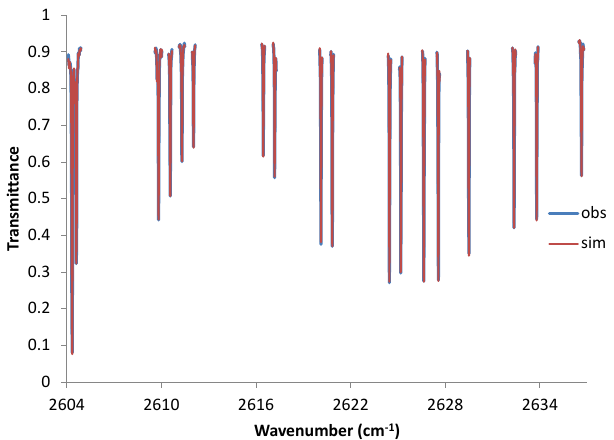
Figure 3d. Same as Fig. 3c but for TH =